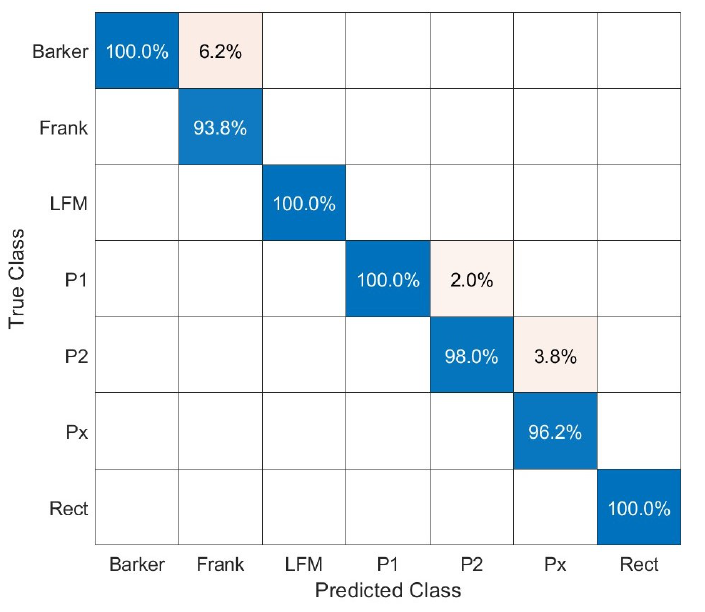
Figure 10. Confusion matrix for AWT with Morse wavelet parameters: γ = 9, β = 27.